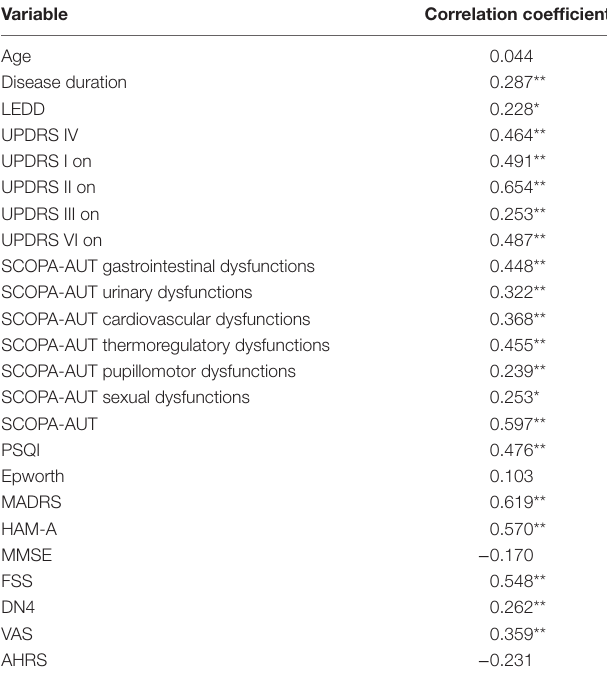
TaBle 5 | Correlation between motor and non-motor features and the PDQ39- SI (Spearman test).